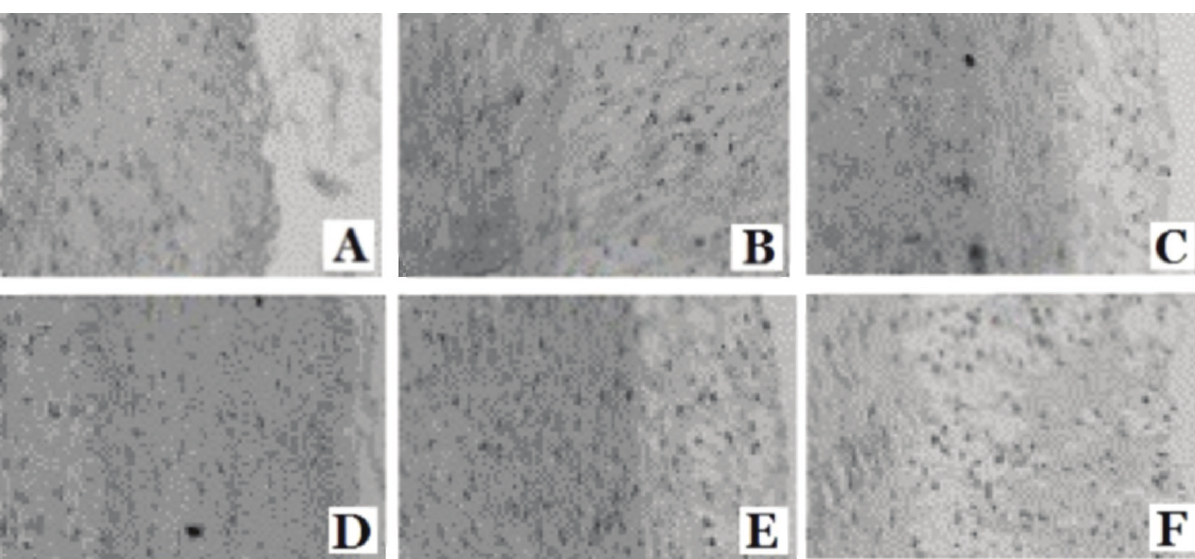
Fig. 1. Light microscopy a ortic observation results. (a) Normal group; (b) model group; (c) simvastatin group; (d) high-dose group; (e) medium-dose group; (f) low-dose group.